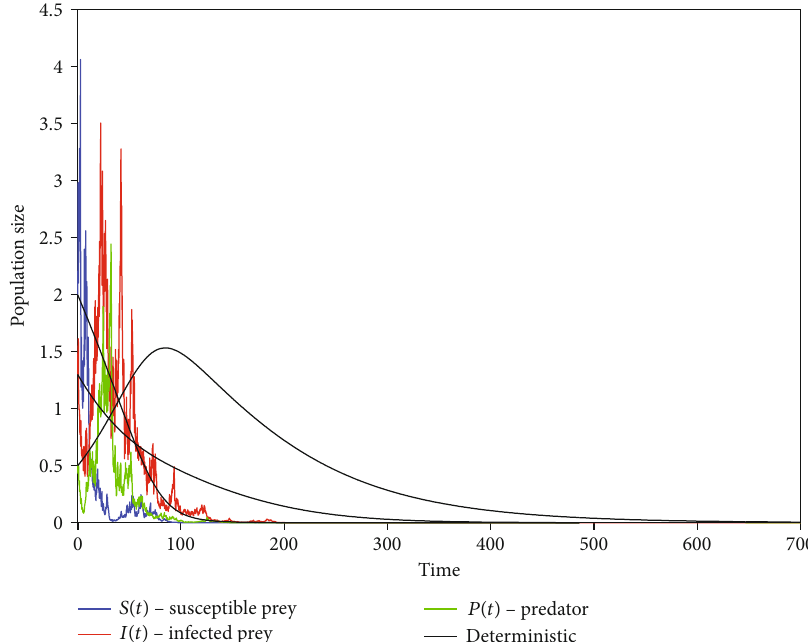
Figure 5: Simulation showing that the solution curves of both deterministic system (11) and corresponding stochastic system (23) are extinct with σ = 0 : 5, σ = 0 : 2, σ = 0 : 3 1 2 3